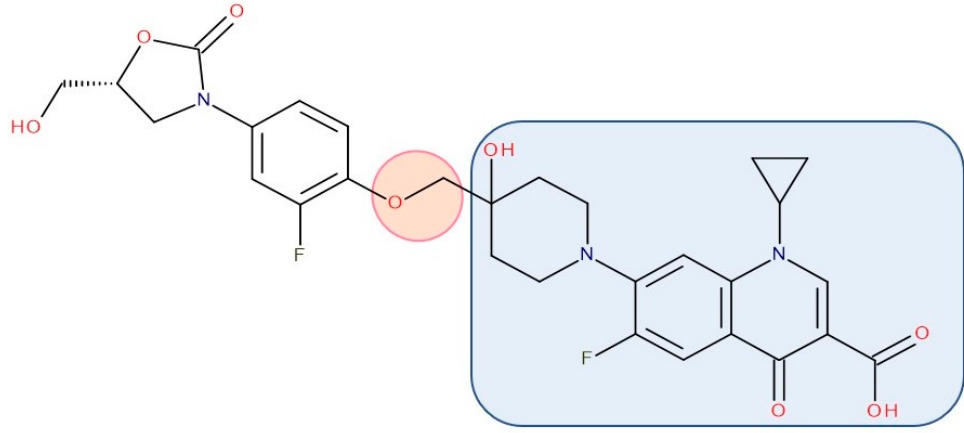
Figure 8. Antibiotic–antibiotic hybrid containing an FQN: tedizolid derivative–linker–ciprofloxacin derivative (Cadazolid); the linker is highlighted with the orange circle while the QN/FQN unit is highlighted by the blue rectangle [236].